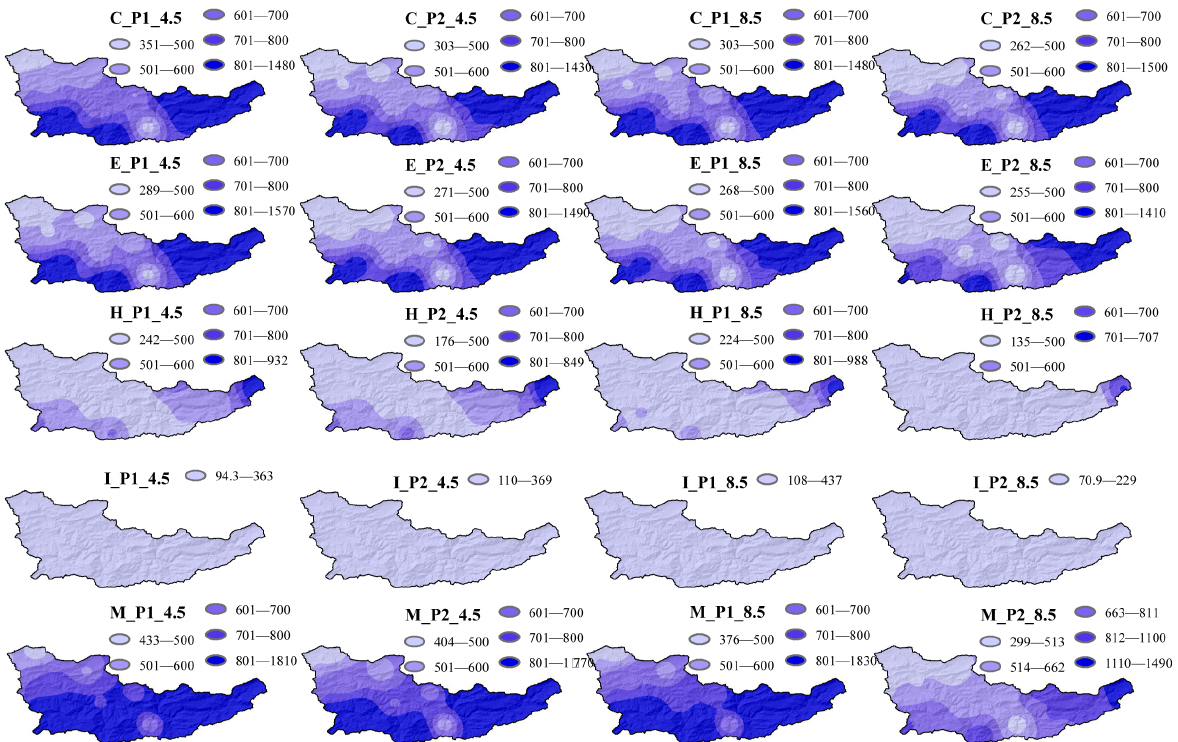
Figure 5. Future changes of precipitation of the RCMs under RCP4.5 and RCP8.5 for the periods